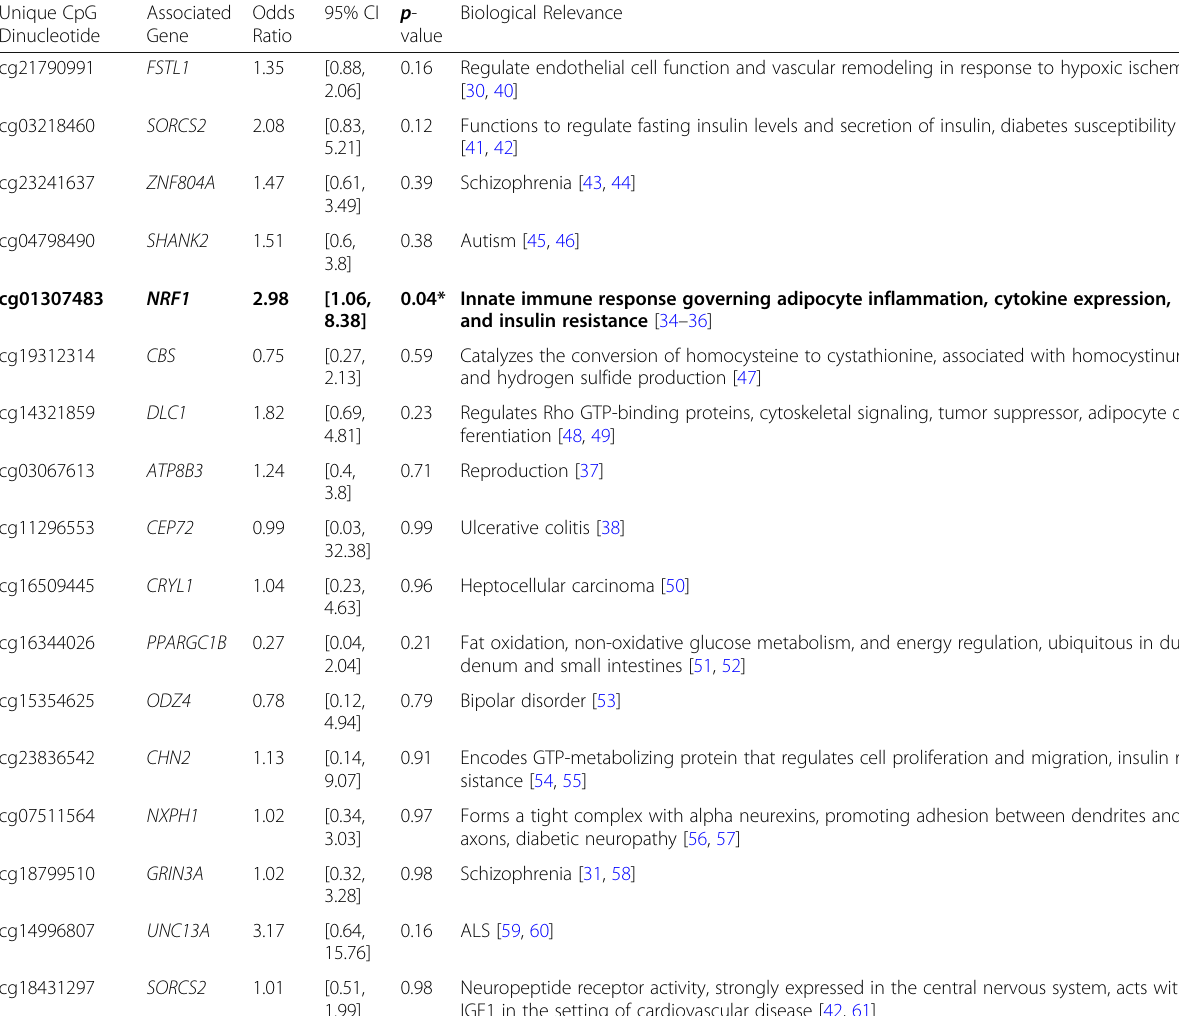
Table 3 Association of Baseline Methylation a at Each CpG Dinucleotide With Child Obesity Status at 36-Month Follow-Up Unique CpG Associated Dinucleotide